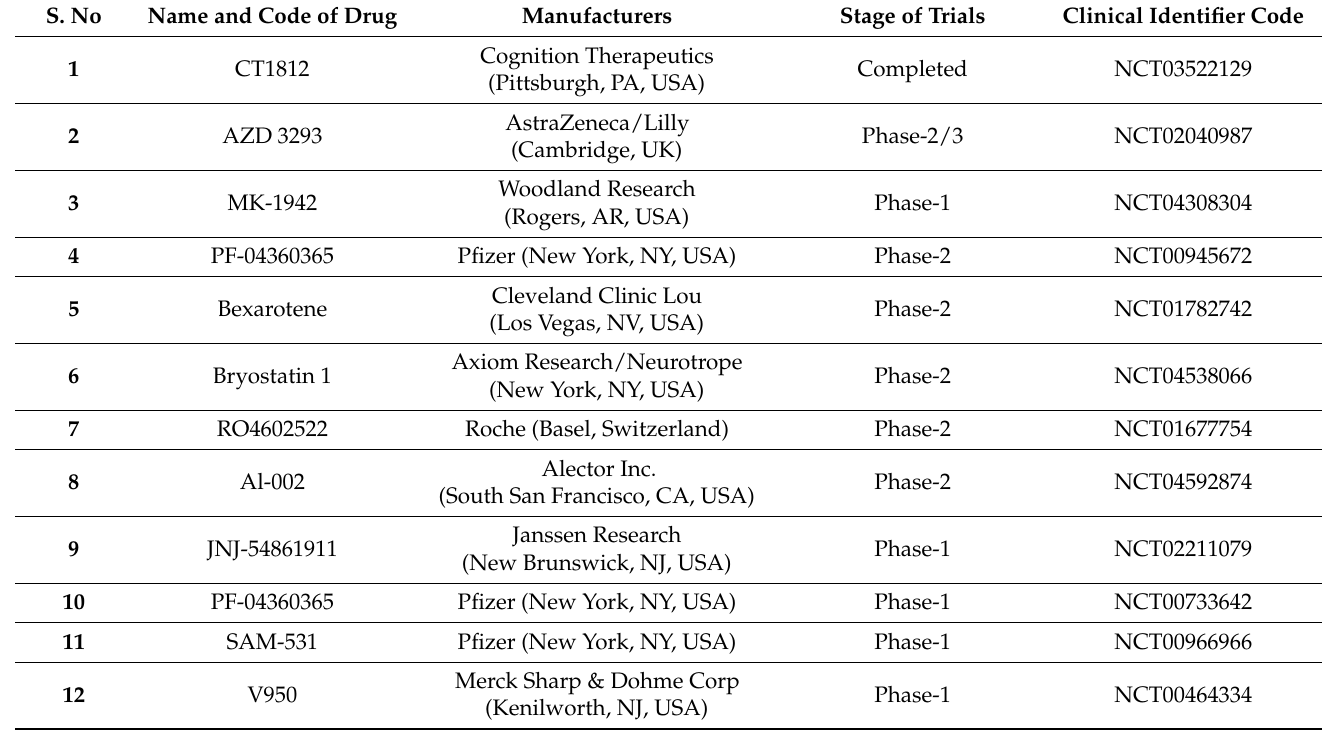
Table 1. List of Drugs for Treatment of Alzheimer’s disease in Numerous Stages of Trials. S.